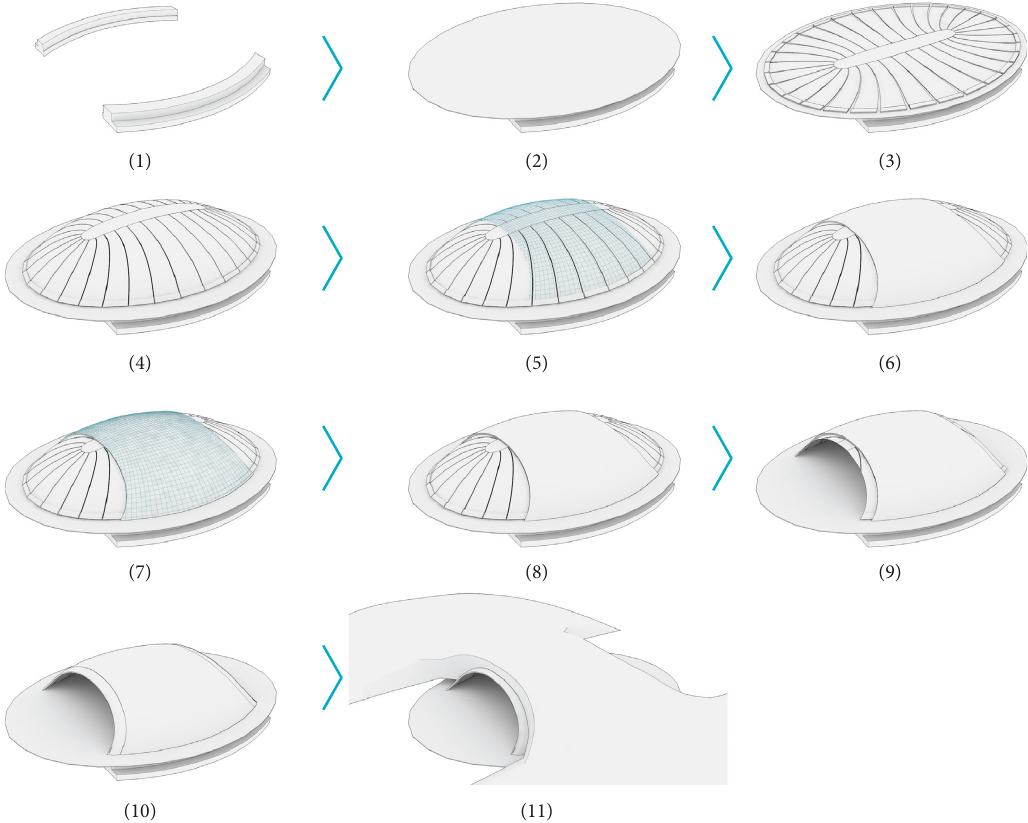
Figure 3: Work steps for the construction of the deer overpass: (1) manufacturing of the foundations; (2) production of the flat working surface out of concrete (the tension plate for the building condition); (3) concreting of the flat concrete plate for the transformation process (thickness 100m, weight 546t); (4) transformation of the initially flat hardened concrete plate to the designed shell; (5)–(8) production of the additional reinforced concrete in layers (total thickness 350mm); (9) cutting out of the portals; (10) production of the edge beam; (11) production of the earth back filling